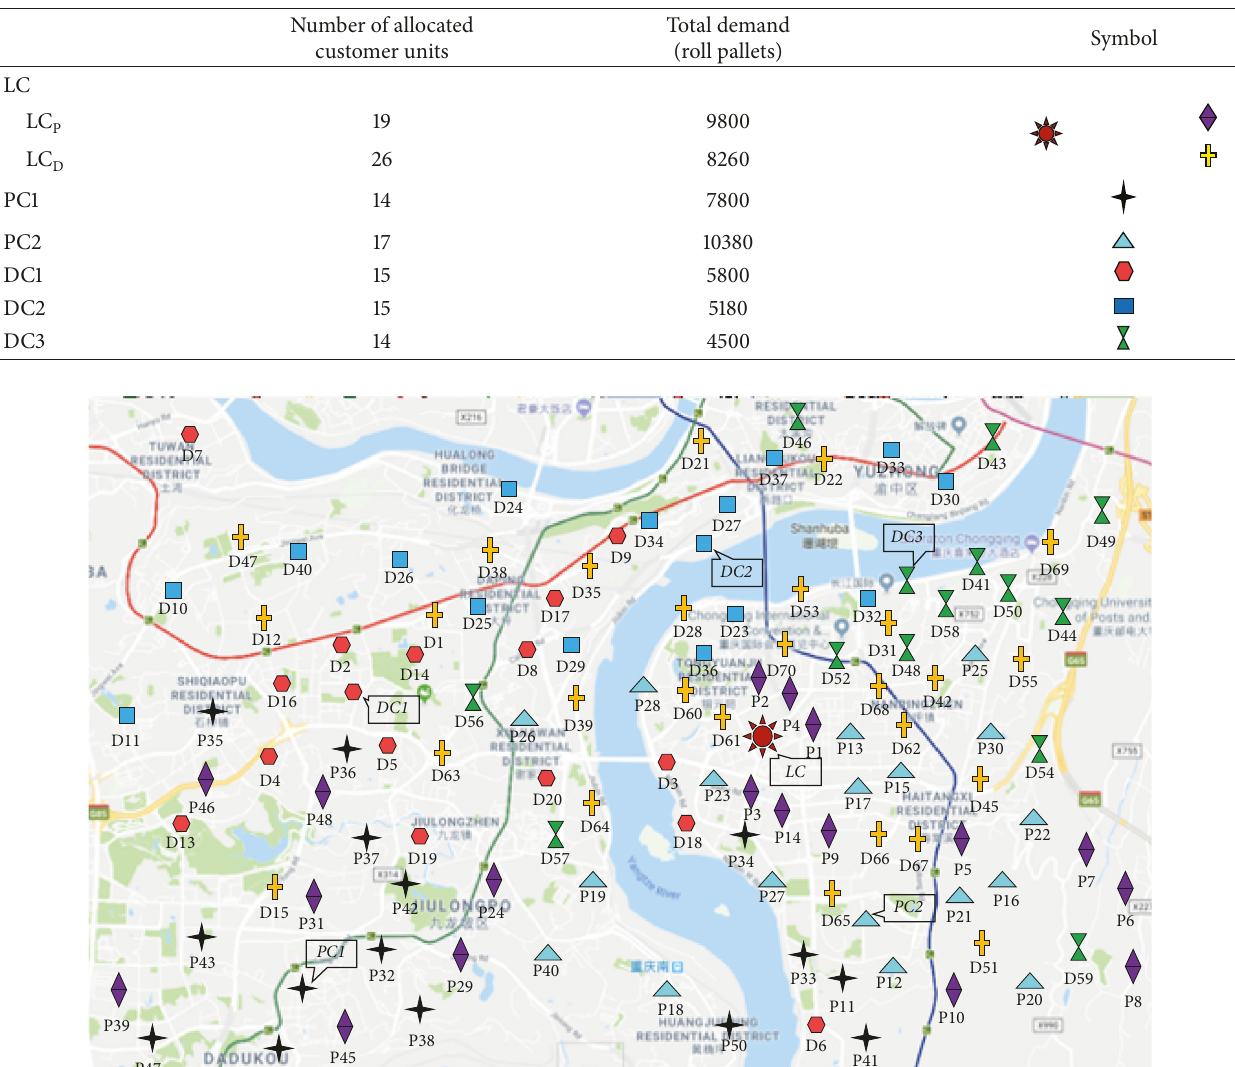
Table 2: Characteristics of six logistics facilities.